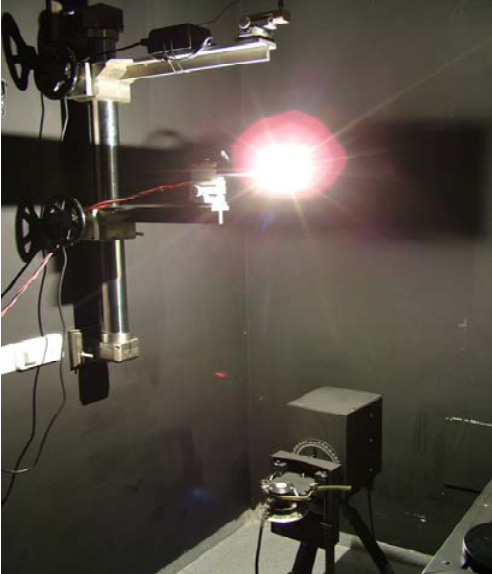
Figure 13. Photograph of the test carried out in the INTA calibration laboratory to calculate the cosine error of the